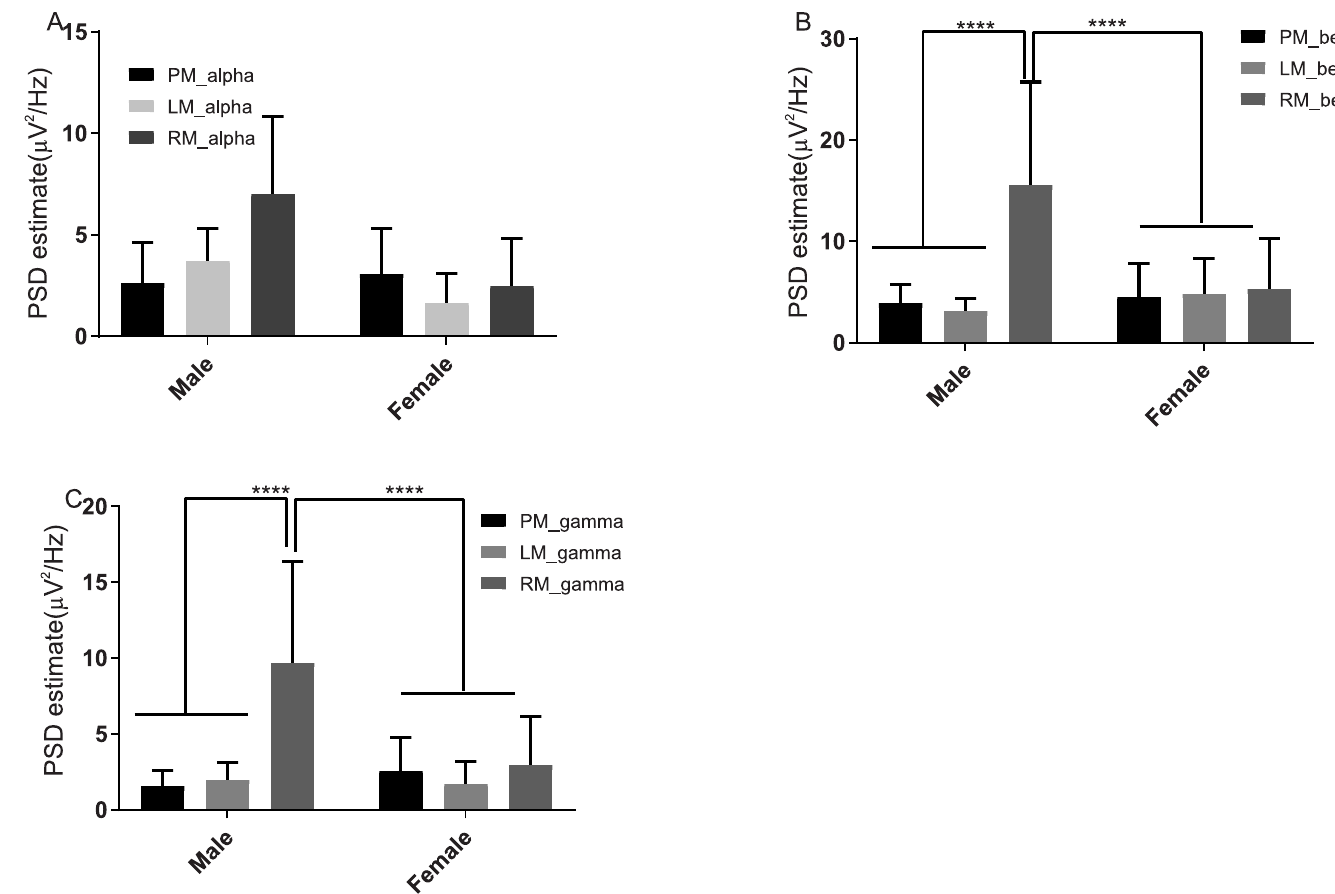
Fig 5. Significant left and right movement in male and female subjects in the central region electrodes among β & γ oscillations. (A, B, C) Variability between the male and female subjects for the tasks of premovement (PM) left movement (LM) and right movement (RM). (A) α oscillations for premovement task of male subjects (2.609 ± 2.025) female subjects (3.091 ± 2.245) have not shown any statistical significance similarly for left movement and right movement (p value > 0.9999), (B) β and (C) γ oscillations have shown significant differences were presented with p value < 0.0001 (12 sample trials of Male subjects, 12 sample trials of female